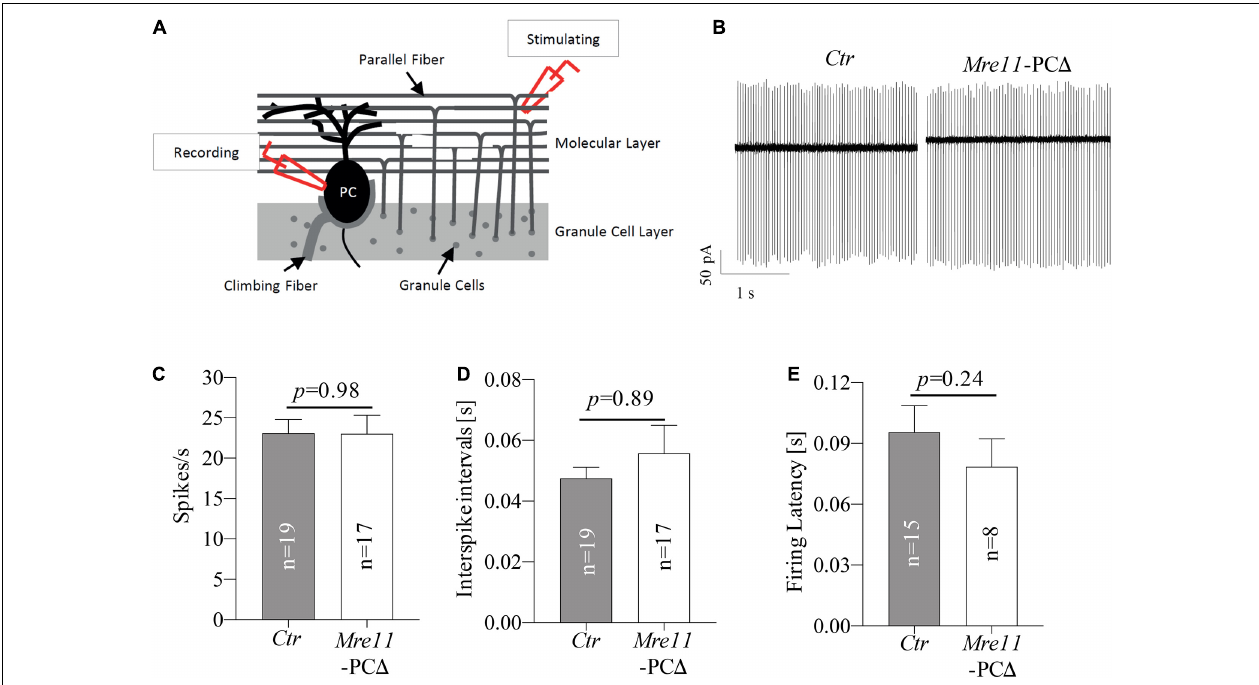
FIGURE 6 | Mre11 -PC (cid:49) Purkinje cells have regular intrinsic activity. (A) Schematic representation of cerebellar loose-patch electrophysiology measurements on Purkinje cell soma and stimulation of parallel fiber-Purkinje cell synapses. PC: Purkinje cell. (B) Sample traces from passive recordings of the spontaneous tonic activity of Purkinje cells in controls ( Ctr ) and Mre11 -PC (cid:49) mice at the age of 18 months. (C) Passive tonic activity as shown by spikes per second (spikes/s) of control ( Ctr ) and Mre11 -PC (cid:49) neurons. (D) Interspike intervals (in s). (E) The firing latency is measured as the time from the parallel fiber stimulation evoked Purkinje cell spike to the next spike of Purkinje cells (in s). The number of neurons measured is indicated within the graph. The P -value of the Student’s t -test is shown in panels (C–E) .